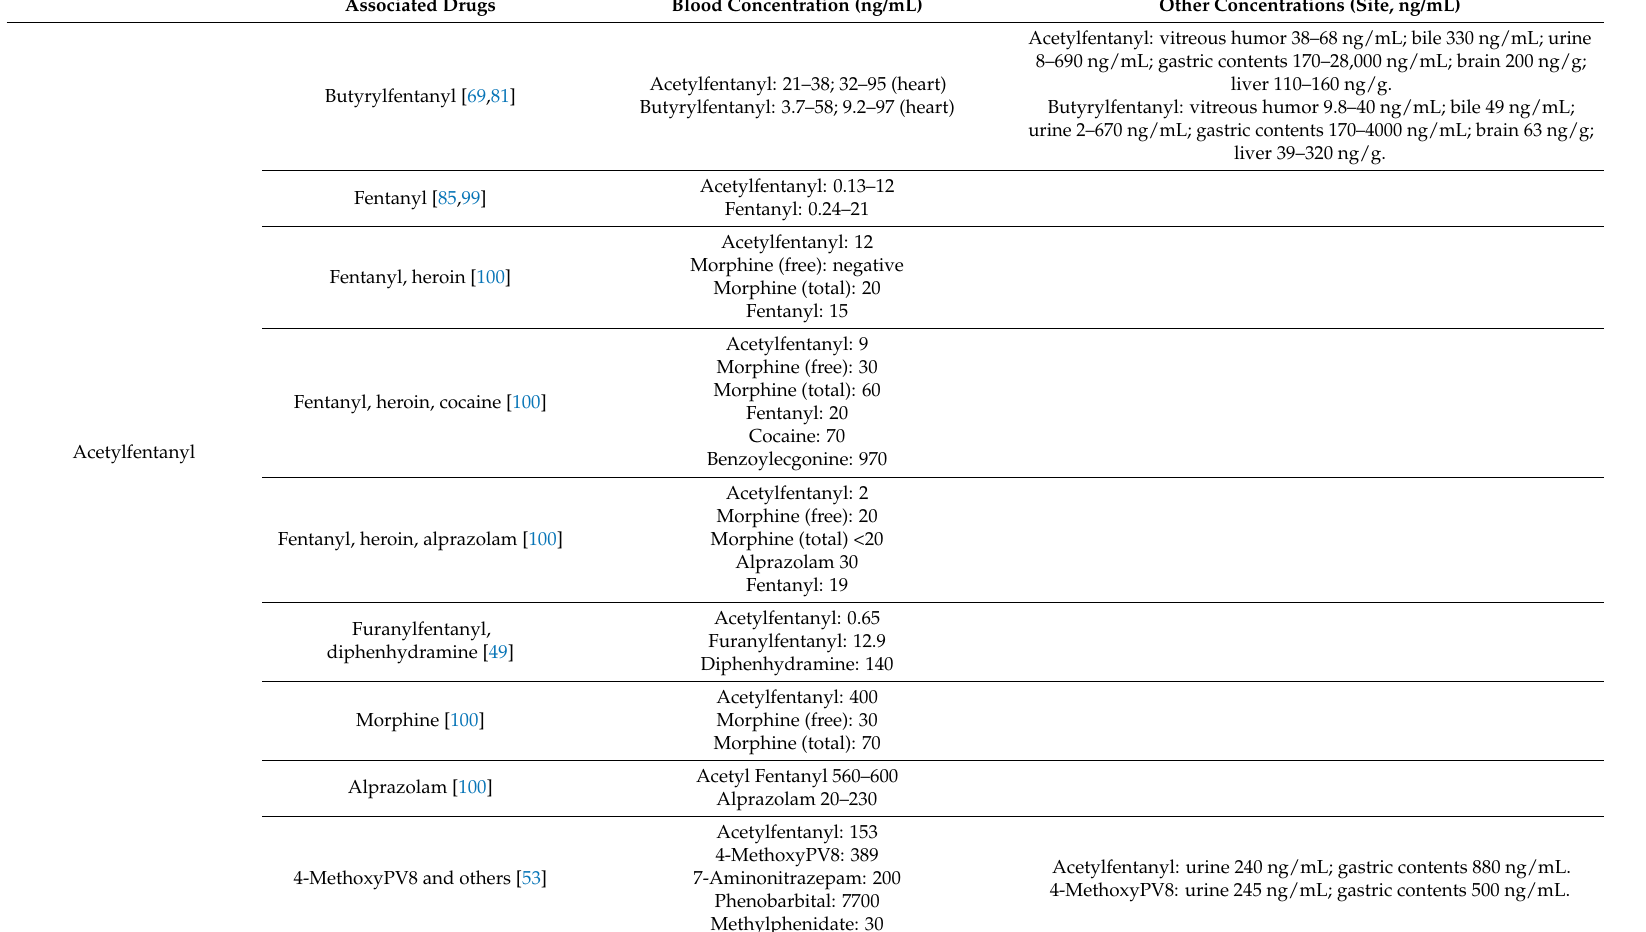
Table 2. Concentrations data reported in multidrug-associated